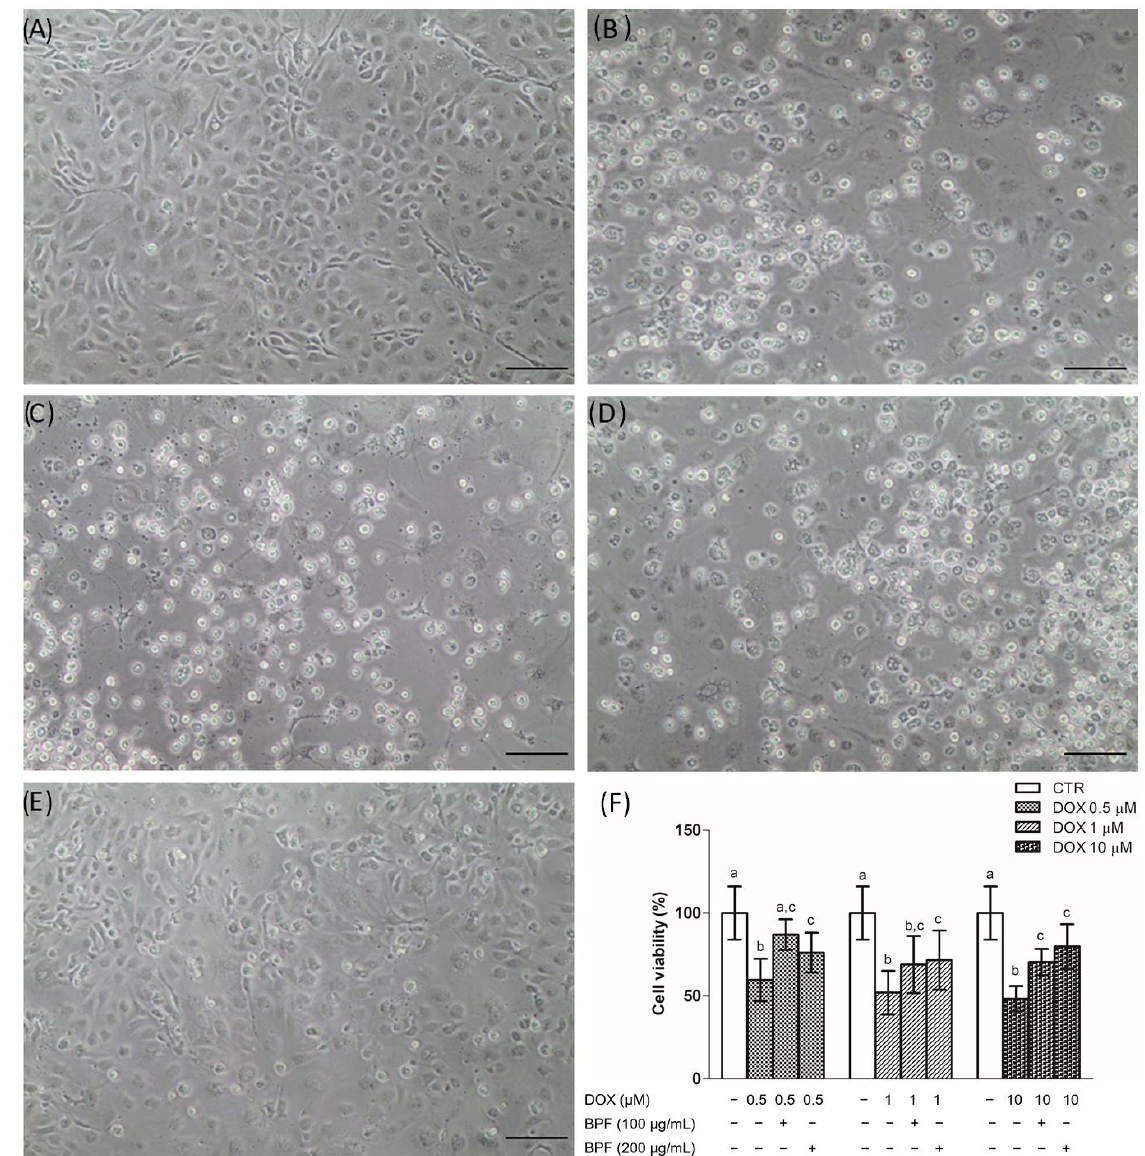
Figure 1. Effect of BPF on DOX-induced pAEC cytotoxicity. ( A – E ) Representative images of pAECs treated with DOX 0.5, 1, 10 µM ( B , C , D , respectively) in the absence or presence of 100 µg/mL BPF ( E ). ( F ) Cell viability quantification: each bar represents the mean ± SD of three independent experiments. Scale bar (―) 100 µm. Different letters above the bars indicate significant differences ( p < 0.05, one-way ANOVA, post hoc Tuckey comparison test) between each DOX treatment with and without BPF and the control (CTR) group. We compared the remodeling of pAEC metabolism in the presence of DOX with and without BPF. We took two different approaches, one with a simultaneous treatment (DOX + BPF) for 24 h (Figures 2A,B, 3A,B and 4A,B) and another with the recovery of the DOX